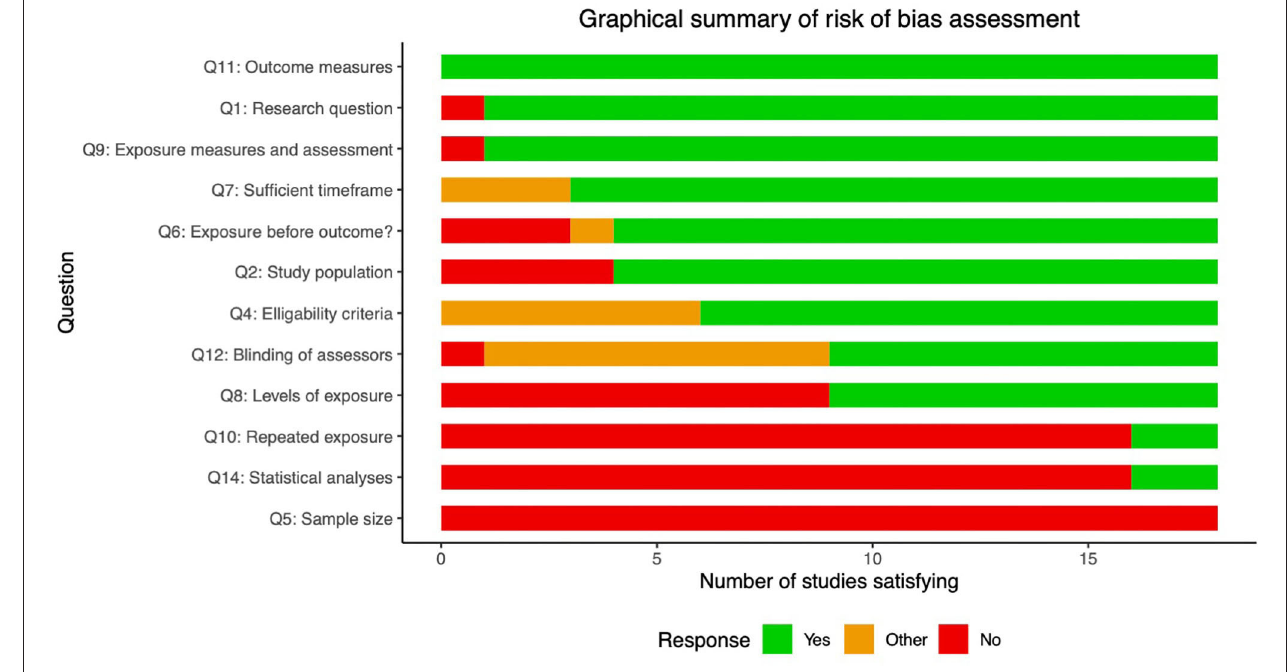
FIGURE 2 | Risk of bias assessment. Summary statistics of risk of bias assessment for the 18 studies included in this review. Descriptions of the relevant questions from the Quality Assessment Tool for Observational Cohort and Cross-Sectional Studies included below. Full explanations of questions and scoring can be found here (https://www.nhlbi.nih.gov/health-topics/study-quality-assessment-tools). Note that questions 3 and 13 were excluded as did not apply to the design used in these studies. 1. Was the research question or objective in this paper clearly stated? 2. Was the Study population clearly specified and defined? 4. Were all the subjects selected or recruited from the same or similar populations (including the same time period)? Were inclusion and exclusion criteria for being in the study prespecified and applied uniformly to all participants? 5. Was a sample size justification, power description, or variance and effect estimates provided? 6. For the analyses in this paper, were the exposure(s) of interest measured prior to the outcome(s) being measured? 7. Was the timeframe sufficient so that one could reasonably expect to see an association between exposure and outcome if it existed? 8. For exposures that can vary in amount or level, did the study examine different levels of the exposure as related to the outcome (e.g., categories of exposure, or exposure measured as continuous variable)? 9. Were the exposure measures (independent variables) clearly defined, valid, reliable, and implemented consistently across all study participants? 10. Was the exposure(s) assessed more than once over time? 11. Were the outcome measures (dependent variables) clearly defined, valid, reliable, and implemented consistently across all study participants? 12. Were the outcome assessors blinded to the exposure status of participants? 13. Were key potential confounding variables measured and adjusted statistically for their impact on the relationship between exposure(s) and